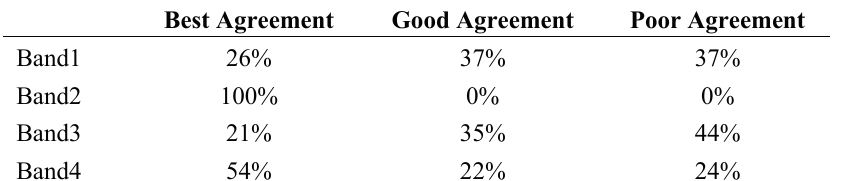
Table 2. The proportion of pixels in each of the three comparison situations.